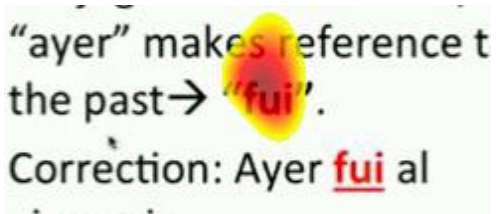
Figure 3. Heat map with an occurrence of profound attention in the tutorial video.